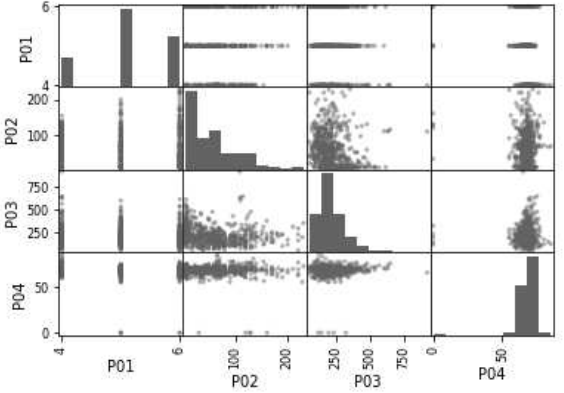
Figure 8. Scatterplot of the parameters considered in the second